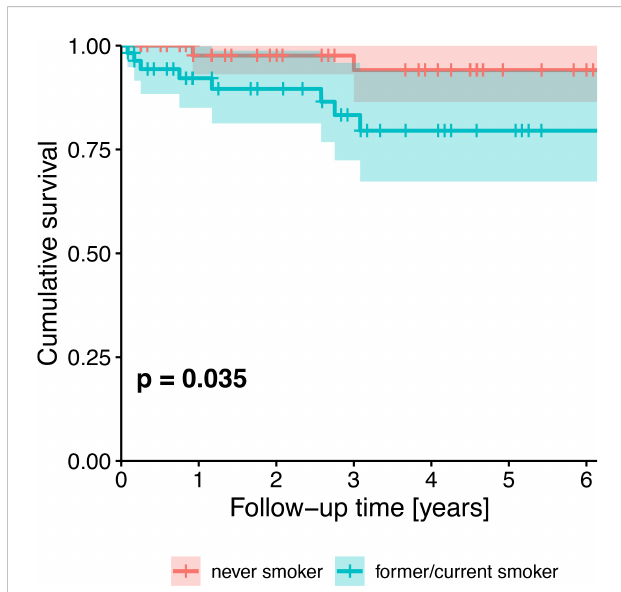
FIGURE 3 Kaplan-Meier survival plot showing the univariate effect of HPV status (never smoker vs. former/current smoker) on survival of all patients. P- value from likelihood ratio test against the null model.